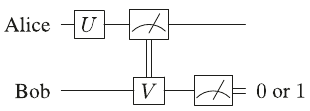
Fig. 6 Ansatz used for fi nding QSD protocols with LOCCNet. Alice performs a unitary gate on her qubit and measures. Then Bob performs on his qubit a unitary gate chosen based on Alice ’ s measurement result. Bob ’ s measurement outcome is supposed to tell which state the input state is.